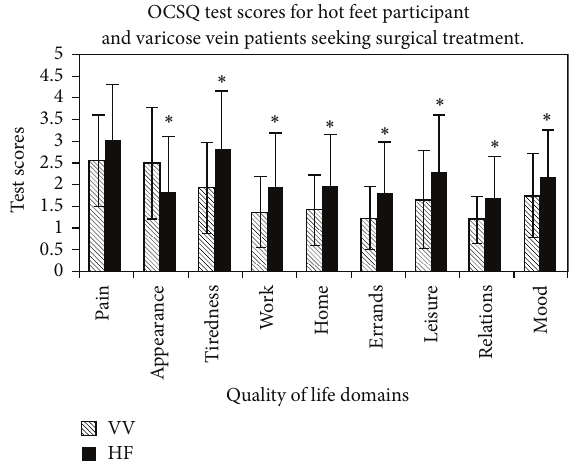
Figure 2: Otago Condition Specific Questionnaire (OCSQ) test scores: VV = varicose veins; HF = hot feet; error bars indicates standard deviations; ∗ indicate significant differences between the varicose vein and hot feet population test scores ( 𝑃 < 0.001